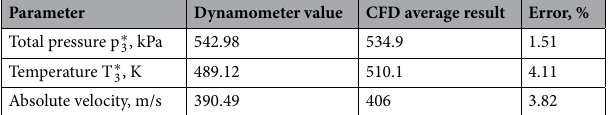
Table 2. Comparison of CFD and experimental data from the test stand.